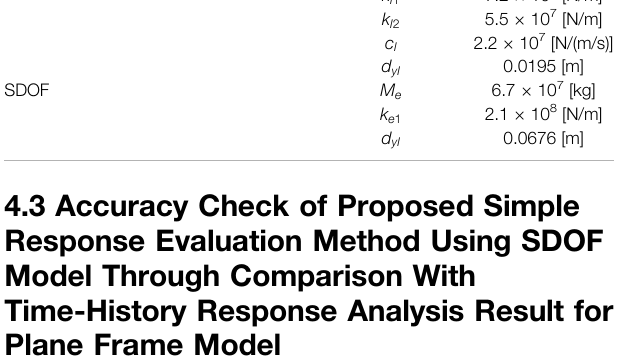
Frontiers in Built Environment |